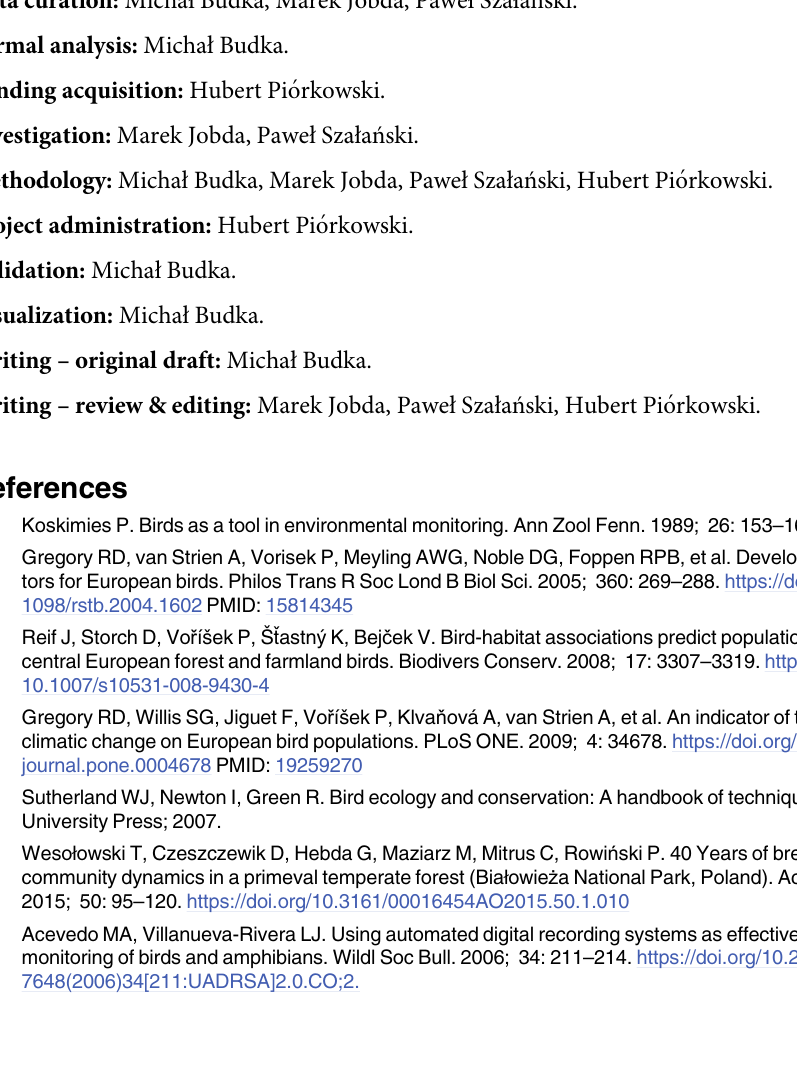
S2 Table. List of bird species defined as meadow and farmland species. S3 Table. Occurrence of a particular bird species. Table shows: the number of surveys in which species was observed, the number of recording sites in which species was observed, the number of detections by a recorder, the number of detections by a human-observer. S4 Table. List of bird species detected only by recorder and only by human-observer.